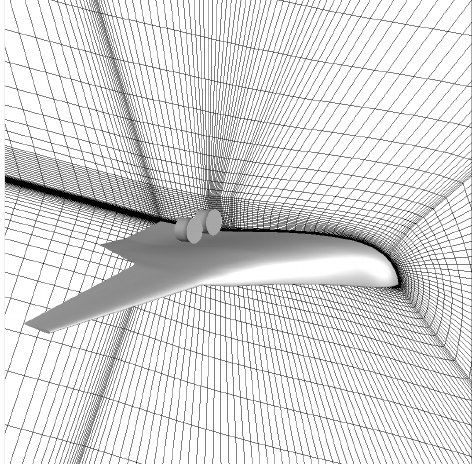
Figure 5. Computational mesh for the CFD